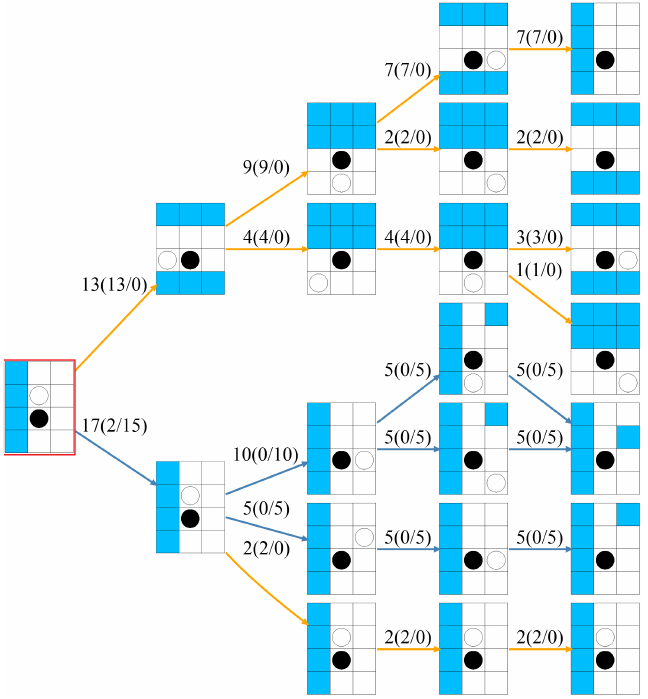
Figure 7. State transitions for Subject 1 starting from an adjacent